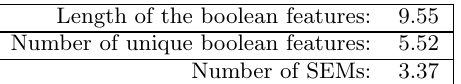
Table 6: Statistics (averaged per user) for the fre- quent pattern matching